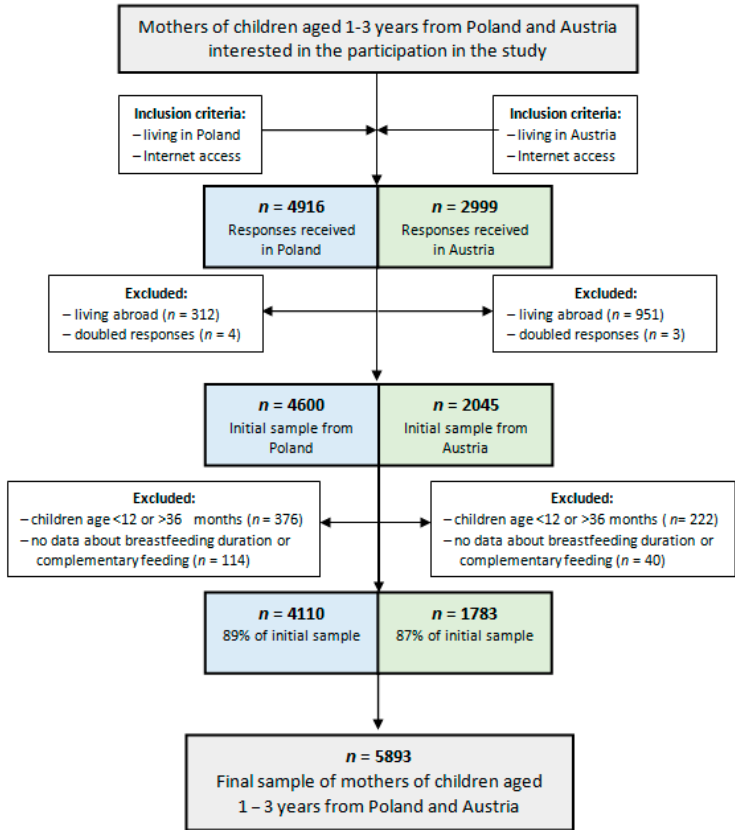
Figure 1. Flowchart of study sample collection.